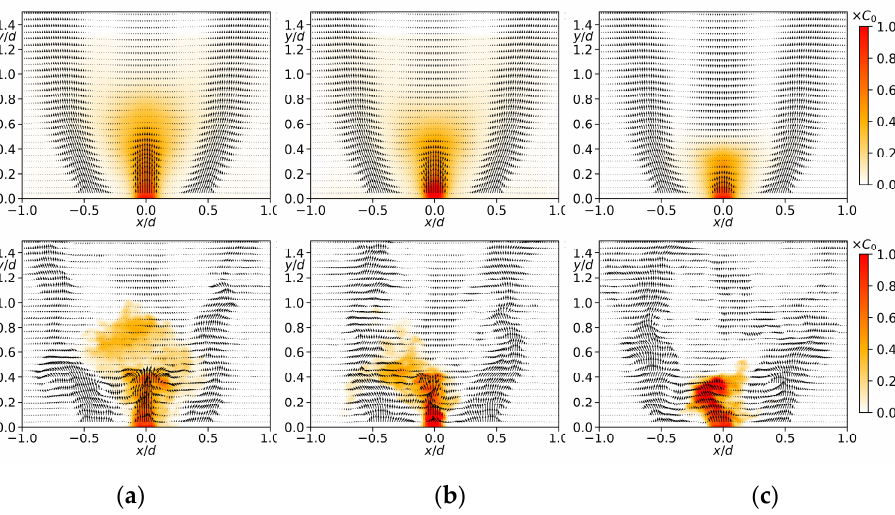
Figure 3. Mean and instantaneous concentration and velocity fields for gas turbine combustor with pilot jet of ( a ) methane, ( b ) neon, and ( c )